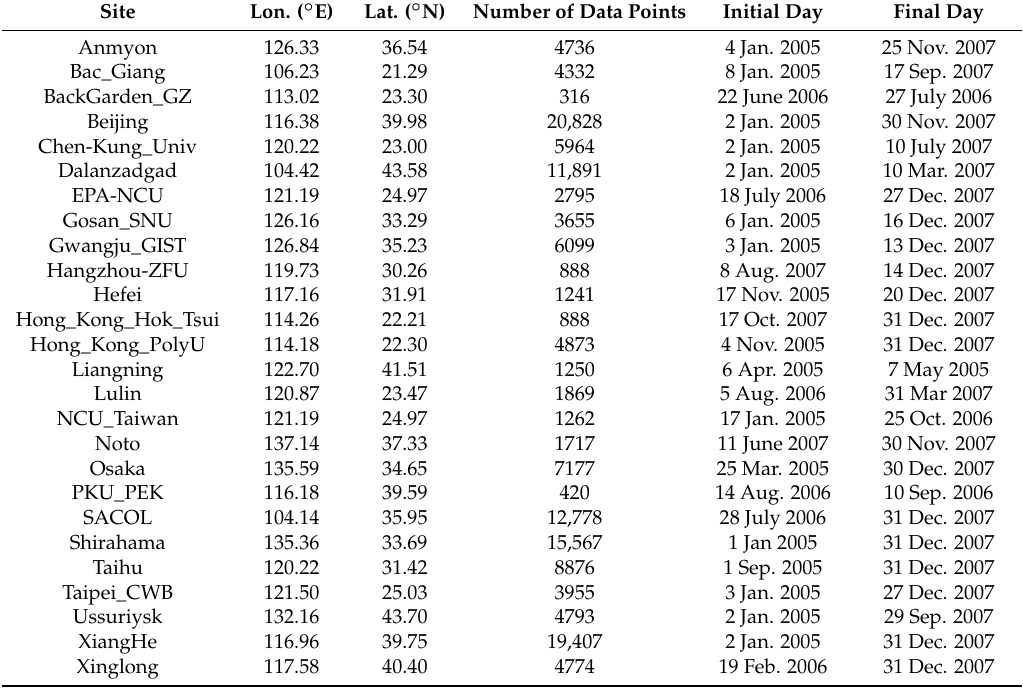
Table 2. List of AERONET sites from which the four level 2.0 products were used to validate retrieval results. The number of data points denotes the number of AOD measurements from 2005 to 2007. The initial and final days indicate the measurement